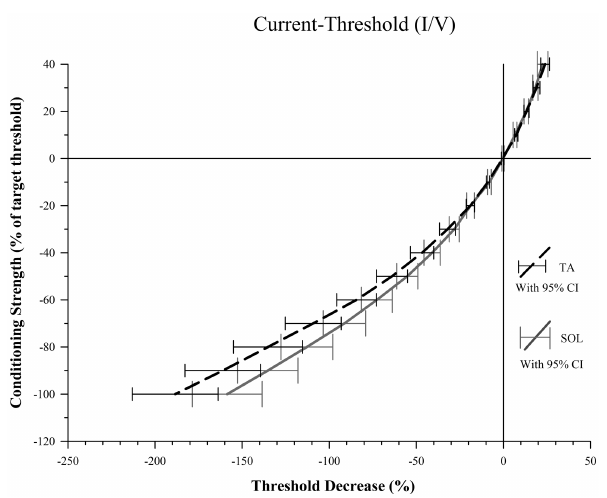
FIGURE 3 | Conditioning current versus threshold. For conditioning strengths of − 80 and − 90% there is a significantly smaller decrease in threshold for SOL compared toTA axons indicative of stronger depolarization current activated by the hyperpolarization for SOL axons.The difference between percent threshold decrease of SOL andTA axons at − 80% was 22.3, 25.8 at − 90% and 29.8 at a conditioning strength